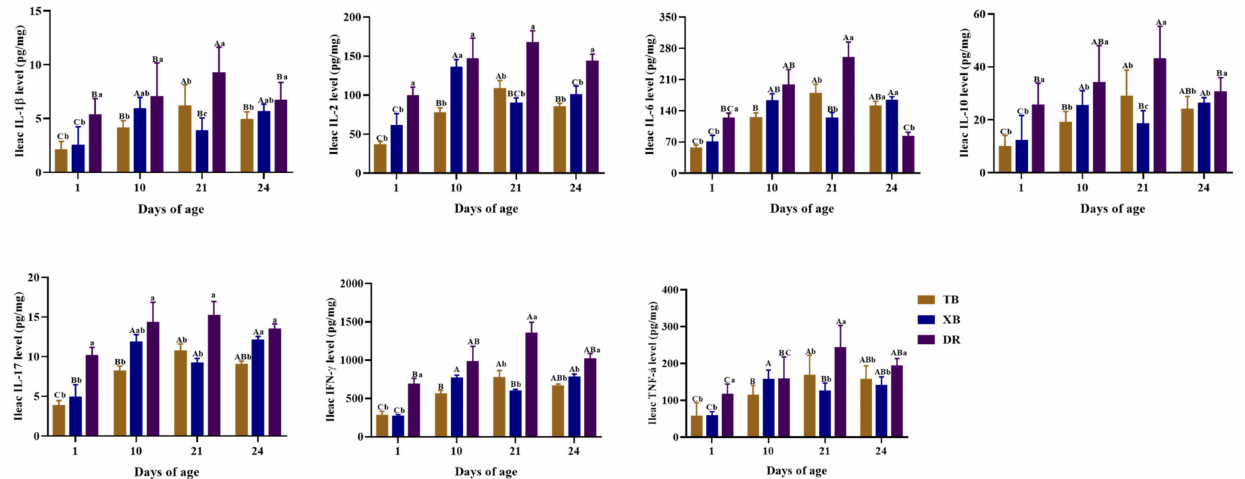
Figure 3. Changes in ileal immuno-cytokine contents of different pig breeds during suckling and weaning periods. Data are presented as means with their pooled SEM ( n = 10). Different capital letters (A, B, and C) indicate significant differences between ages in the same breed ( p < 0.05), and different small letters (a, b, and c) indicate significant differences between breeds at the same age ( p < 0.05). IL, interleukin; IFN, interferon; TNF, tumor necrosis factor; DR, Duroc piglet; TB, Taoyuan black piglet; XB, Xiangcun black